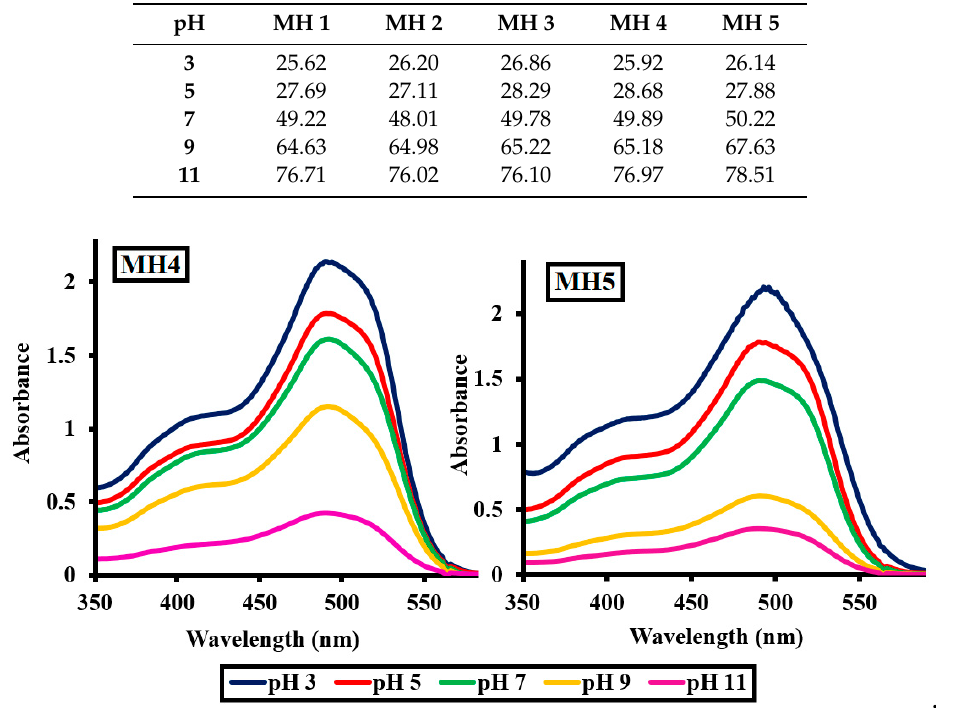
Table 8. Photocatalytic degradation of alizarin red (AR) dye (200 ppm) by MH1–MH5 (0.02 g) after 60 min of photocatalytic activity.